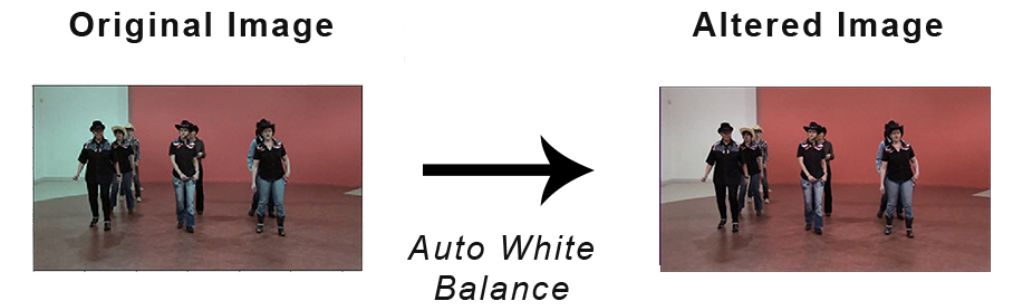
Figure 2. Example of an image before and after white